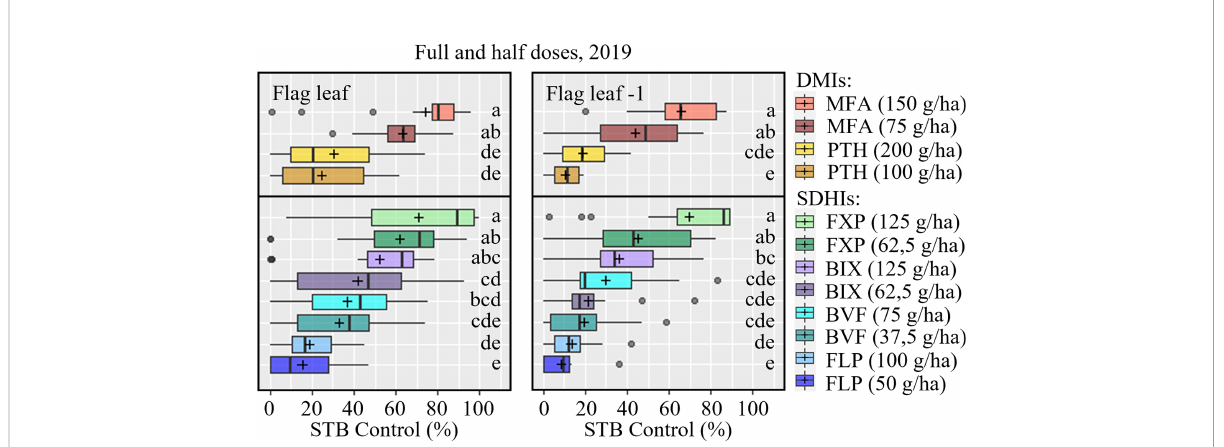
FIGURE 4 STB control (%) of full and half doses on fl ag leaves (left) and F-1 leaves (right) were assessed at growth stage 73-75, 33-55 days after application in fi ve trials in 2019. The trials were carried out in Denmark, the United Kingdom, Ireland, France, and Germany. The tested fungicides included mefentri fl uconazole (MFA), prothioconazole (PTH), fl uxapyroxad (FXP), bixafen (BIX), benzovindi fl upyr (BVF), fl uopyram (FLP). The line inside the boxes indicates the median and ‘ + ’ indicates the average. Different letters represent signi fi cant differences between treatments within boxplot as determined by Dunn ’ s